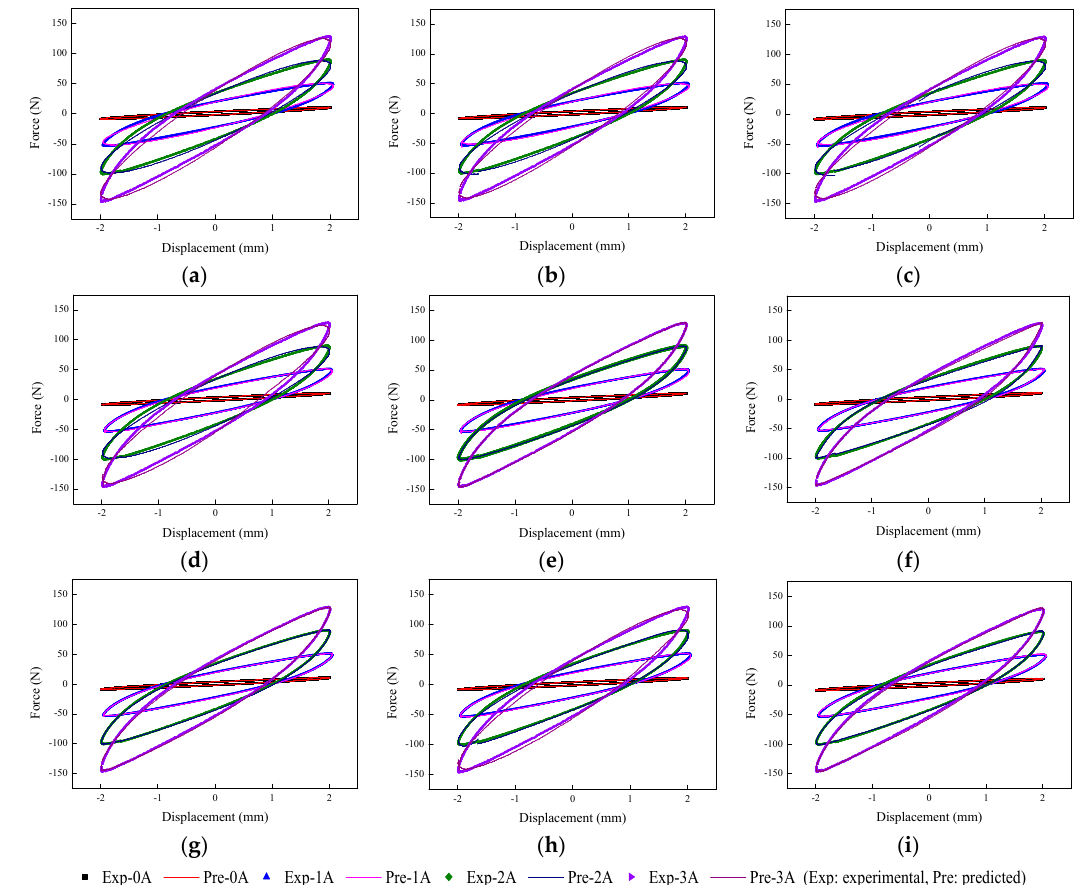
Figure 15. Comparisons of force–displacement responses between experimental results and model predictions when the loading frequency and amplitude are 0.1 Hz and 2 mm. ( a ) Kelvin–Voigt model, ( b ) four-parameter viscoelastic model, ( c ) rheological model, ( d ) BW model, ( e ) improved BW model, ( f ) Dahl model, ( g ) improved LuGre friction model, ( h ) strain stiffening model, and ( i ) hyperbolic hysteresis model.